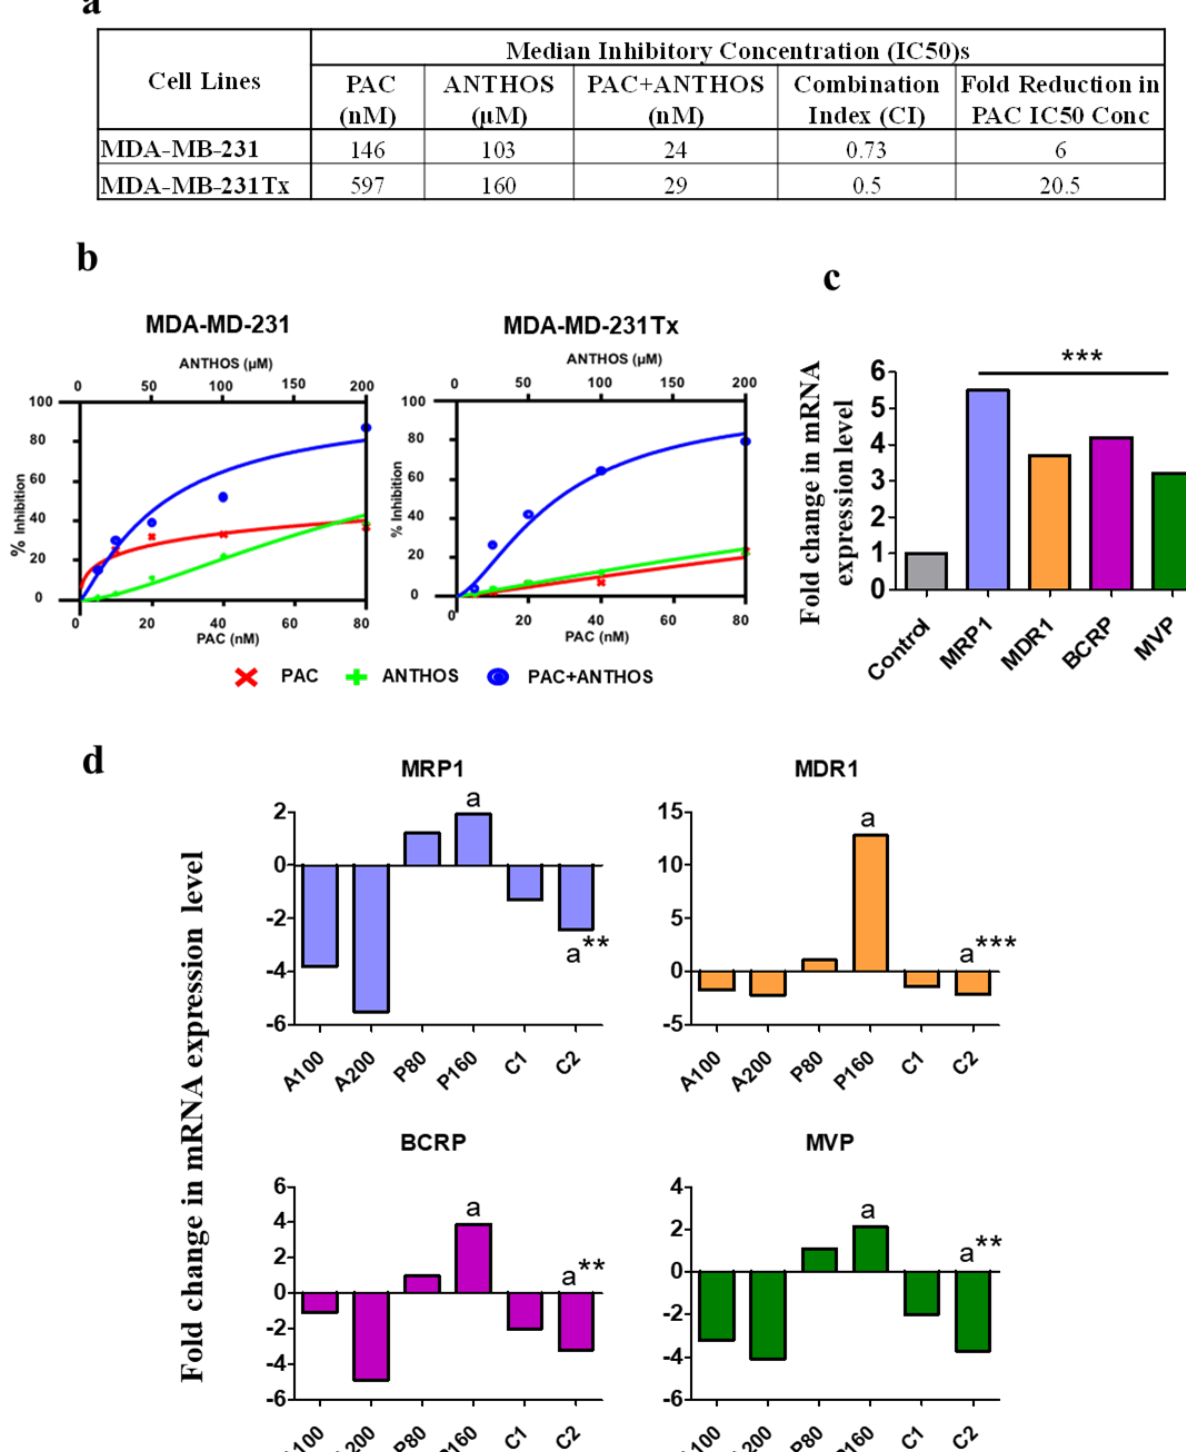
Figure 5. Anti-proliferative and synergistic activity of Anthos against parental and paclitaxel (PAC)-resistant BC cells and effects on resistant gene markers: ( a , b ) Drug-sensitive (MDA-MB-231) and drug-resistant (MDA-MB-231Tx) cells were treated with Anthos and PAC, alone and in combination, at various concentrations. Anti-proliferative activity was determined by MTT assay. IC 50 values, of individual and combination treatments, and combination index were calculated using the Calcusyn software; ( c ) Expression levels of resistant gene markers (MRP1, MDR1, BRCP, and MVP) were determined using RT-PCR. The bar graph depicts the fold increase in mRNA expression of resistance proteins in MDA-MB-231Tx cells compared to parental MDA-MB- 231 cells; ( d ) MDA-MB-231Tx were treated with indicated doses